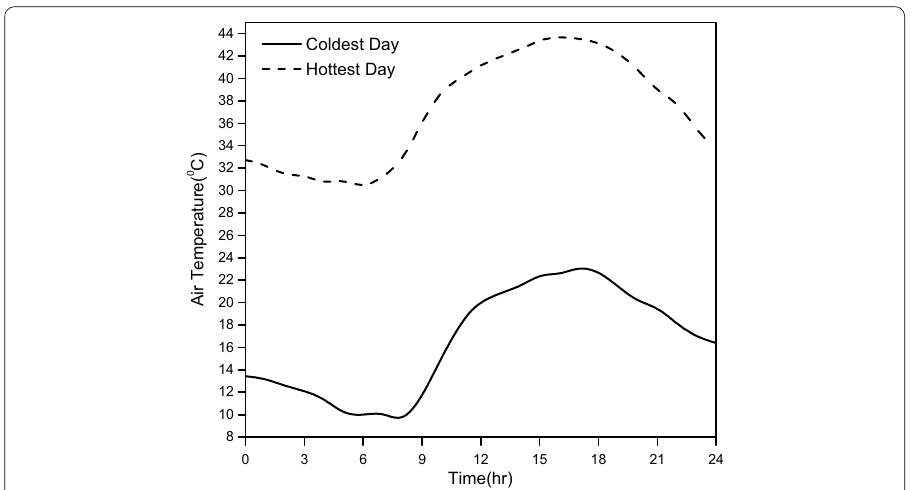
Fig. 2 Ambient air temperature for the hottest day (21st April) and the coldest day (24th January) 2016 in Jamshedpur,